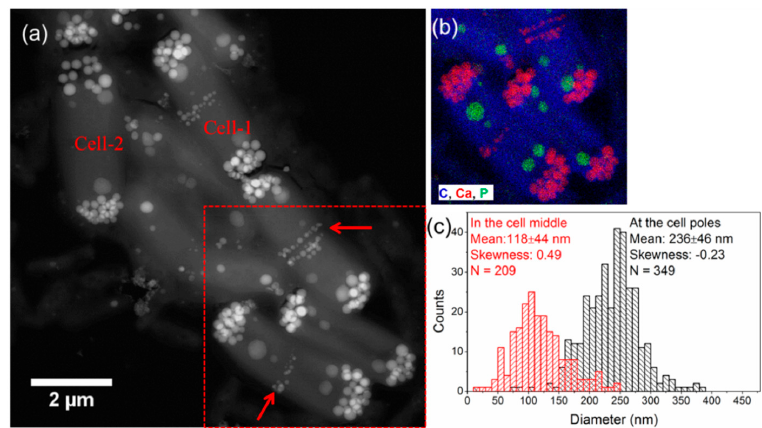
Figure 10. Spatial arrangement and morphological features of carbonates formed by Ca . S. calcipolaris G9 grown in BG-11 for one week. ( a ) HAADF-STEM image of seven cells showing that three cells contain Ca-carbonate inclusions at the cell poles and also at the middle of the cells (red-line arrows). The red-line arrows indicate that carbonate inclusions at mid-cells are generally smaller than those at the cell poles. Cell-1 indicates one cell which contains carbonate inclusions with similar size at the two poles, while Cell-2 seems to have differently sized polar inclusions; ( b ) EDXS element map of a small area indicated by the red-dashed square on the image ( a ) showing the spatial arrangement of carbonate (red colors) and polyphosphate (green colors) inclusions; ( c ) Particle size distributions of carbonates at the cell poles (histogram in black) and at mid-cells (histogram in red).